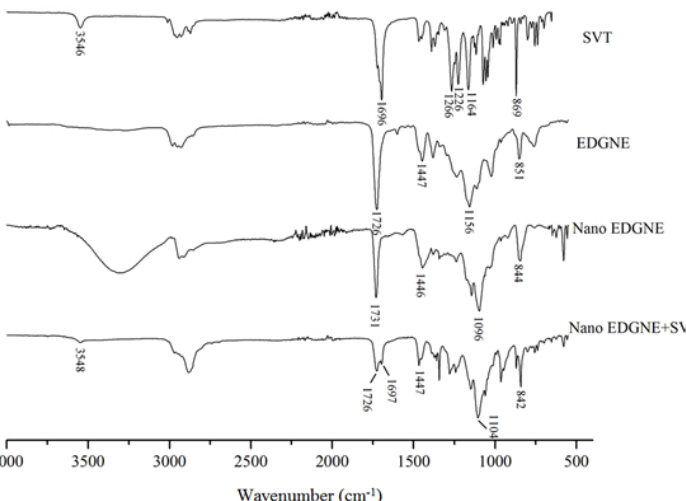
FIGURE 4 - Comparison of absorption spectra in the infrared region for simvastatin (SVT), Eudragit ® NE30D (EDGNE), unloaded Eudragit ® NE30D nanoparticles (Nano EDGNE) and simvastatin-loaded Eudragit ® NE30D nanoparticles (Nano EDGNE+SVT).